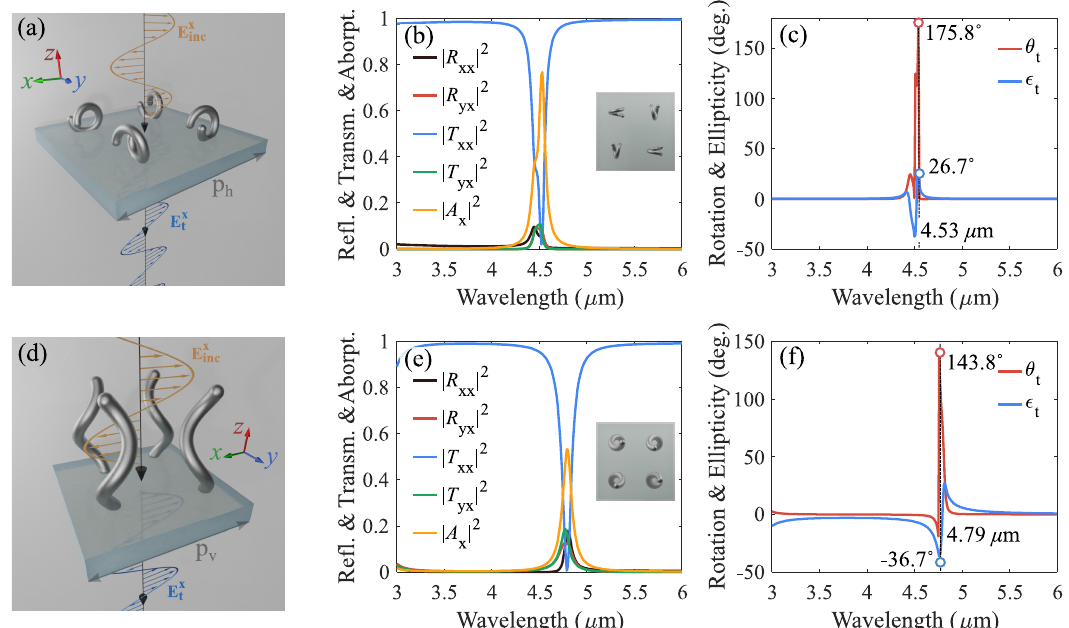
Figure 6. ( a ) The unit cell of a metasurface based on horizontally-oriented helices with the lattice period of p h = 3.3 µ m for copolarized transmission regime. ( b ) Co- and cross-polarized reflectance, transmittance, and absorbance spectra with the top view of the unit cell in the inset. ( c ) The polarization rotation angle θ t and ellipticity (cid:101) t of transmitted waves. ( d ) The unit cell of a metasurface consists of vertically oriented helices with a lattice period of p v = 2 µ m for copolarized transmittance. ( e ) Reflectance, transmittance, and absorbance spectra with the top view of the unit cell in the inset. ( f ) The rotation and ellipticity wavelength dependence of the metasurface based on vertically-oriented